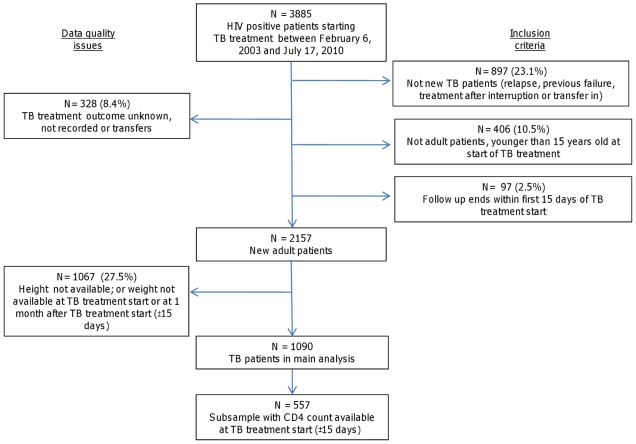
Flow diagram showing sample construction.